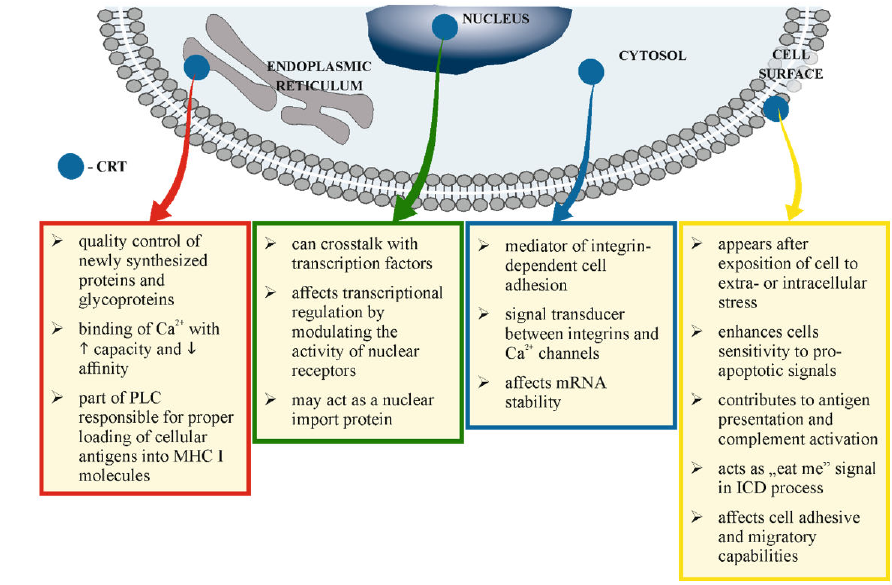
Figure 2. Multiple functions of calreticulin depending on its cell’s